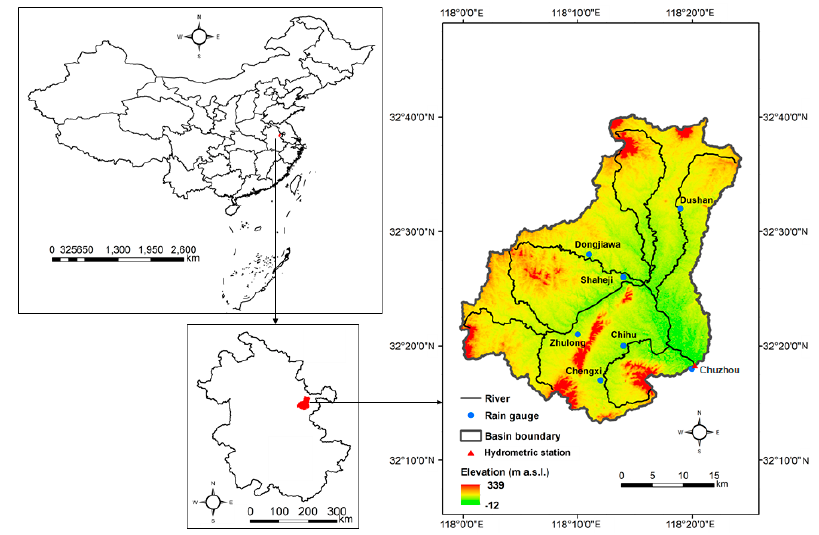
Figure 1. Location of the Qingliu River basin, East China.